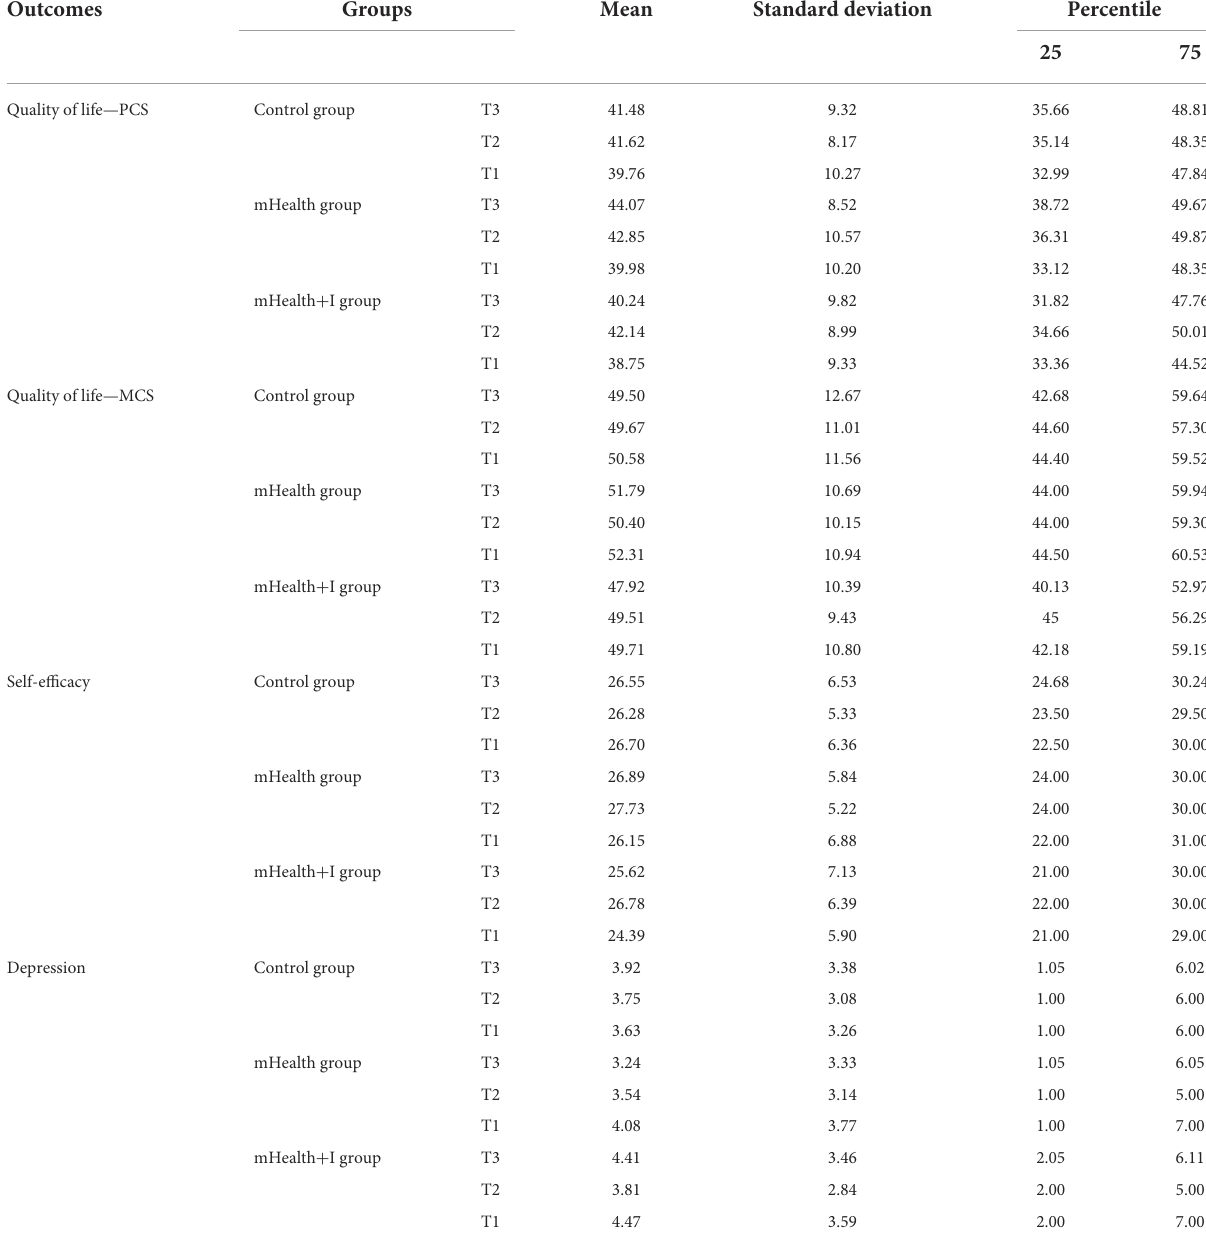
TABLE 2 The mean differences of the outcomes between T1 and T2 for each group. Outcomes Groups Mean Standard deviation Percentile